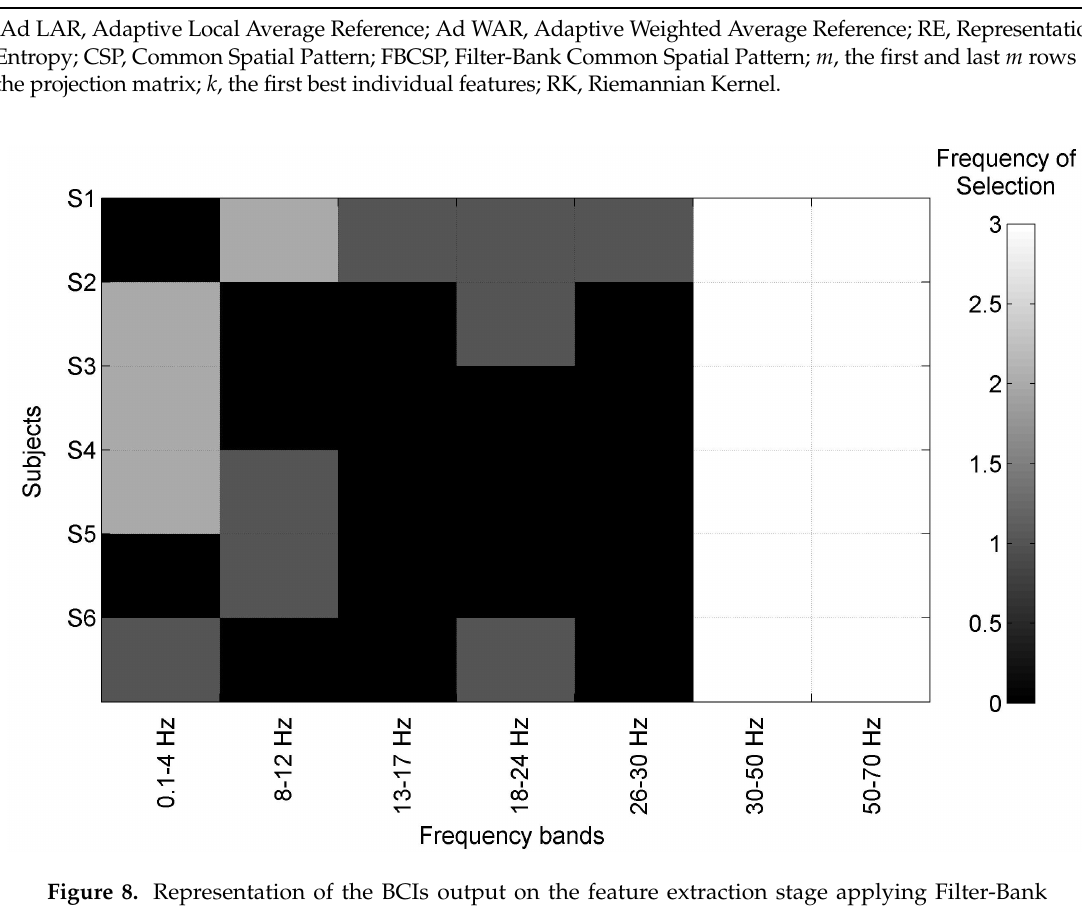
Figure 8. Representation of the BCIs output on the feature extraction stage applying Filter-Bank Common Spatial Filter. The rows represent, for the six subjects, selected features on FC1, FC2, C3, C4, Cz, CP1, and